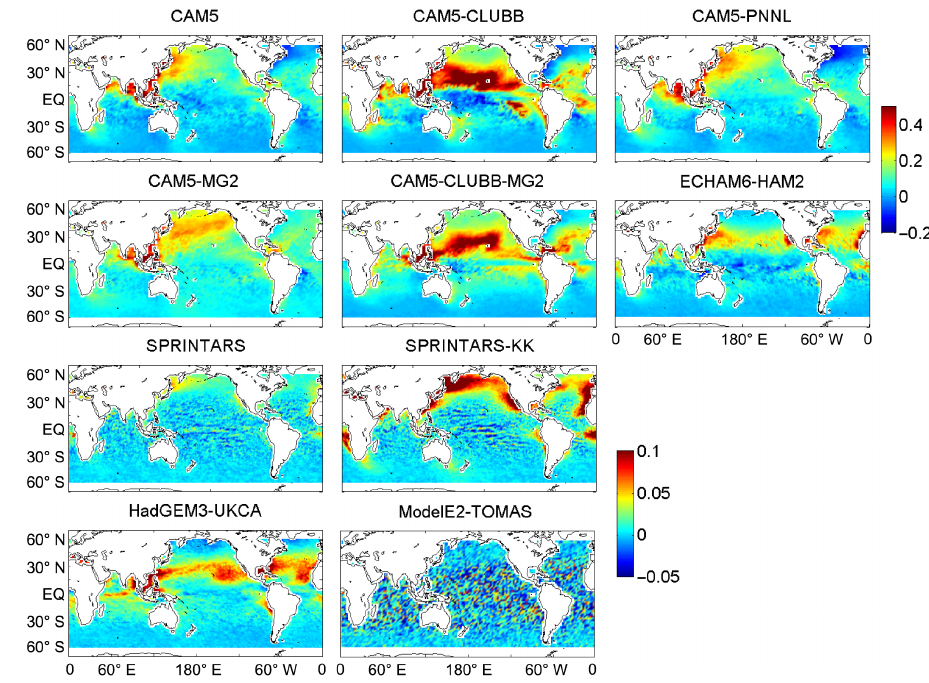
Figure 3. Relative change of annual averaged LWP from PI to PD (dlnLWP) simulations derived from the 10 GCM